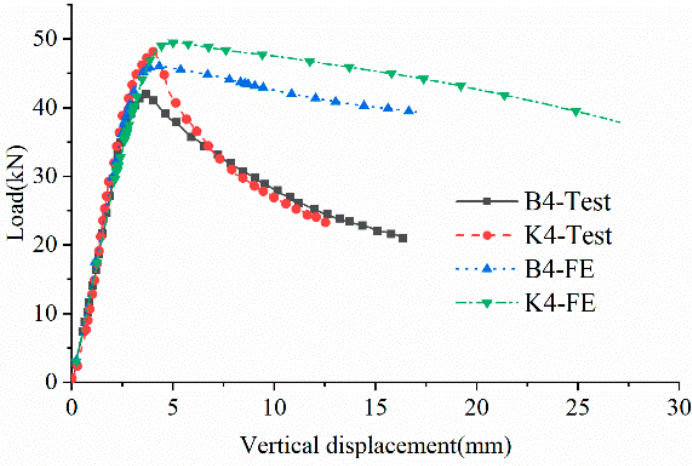
Figure 8. Comparison of experimental and FE analysis results. ( a ) B4 beam in the experiment test; ( b ) B4 beam in the FE analysis; ( c ) K4 beam in the experiment test; ( d ) K4 beam in the FE analysis.